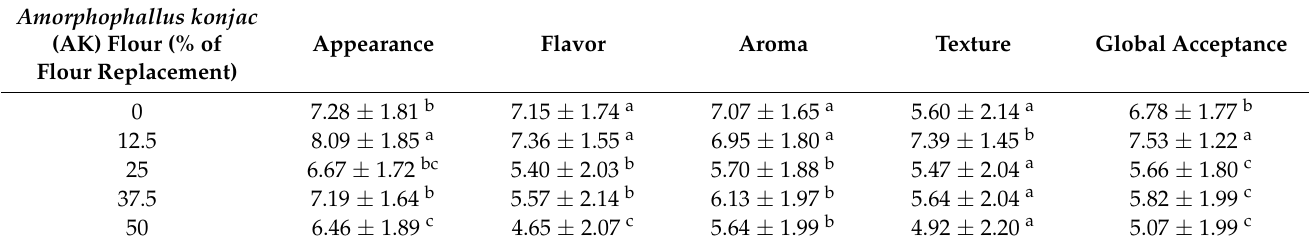
Table 1. Mean and standard deviation of gluten-free bread samples’ acceptance (9-point hedonic scale; n = 110 tasters).